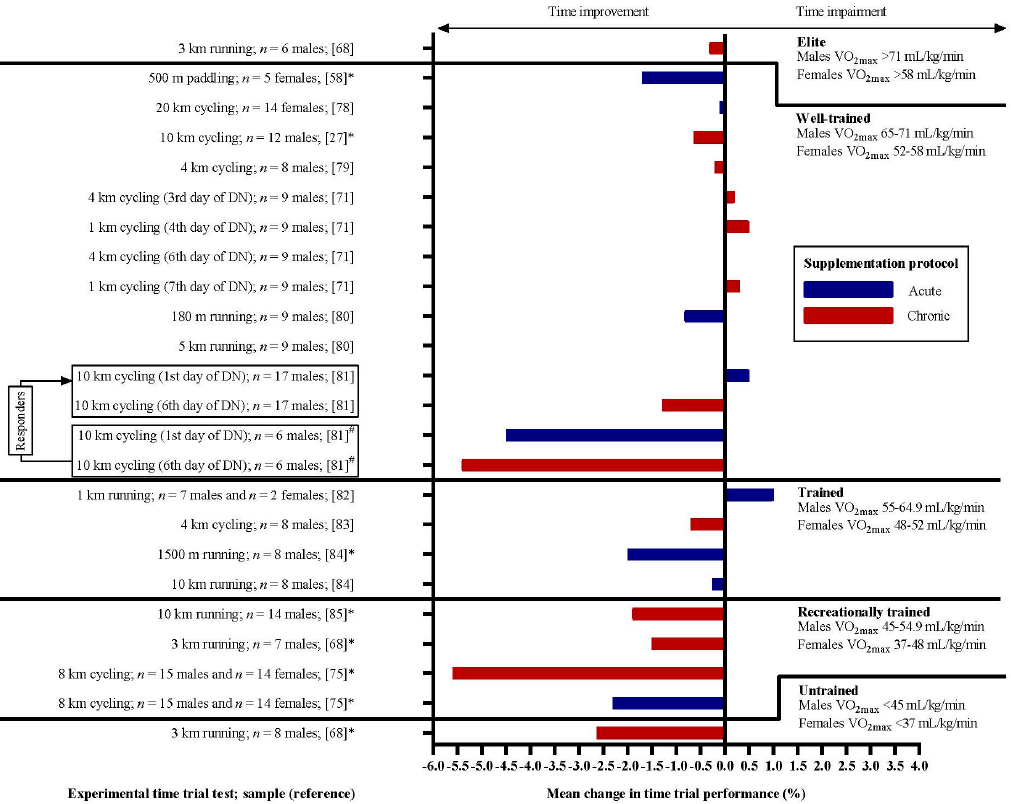
Figure 2. Effects of DN supplementation on TT performance in athletes with different training statuses according to their VO 2max . The graph presents the mean percentual changes in time-to-completion of given tasks in the experimental groups. Negative values represent improvement, as the task was finished in less time (bars to the left from y -axis) following acute (blue bars) or chronic (red bars) supplementation. Cited studies are listed in References [27,58,68,71,75,78–85]. * Statistically significant improvement in performance following DN supplementation; # improvement was observed in 6 of 17 participants dividing the group of well-trained athletes into “responders” and “non-responders”. The two experimental situations are, therefore, divided into four according to the specific reaction to DN supplementation of the participants [81].